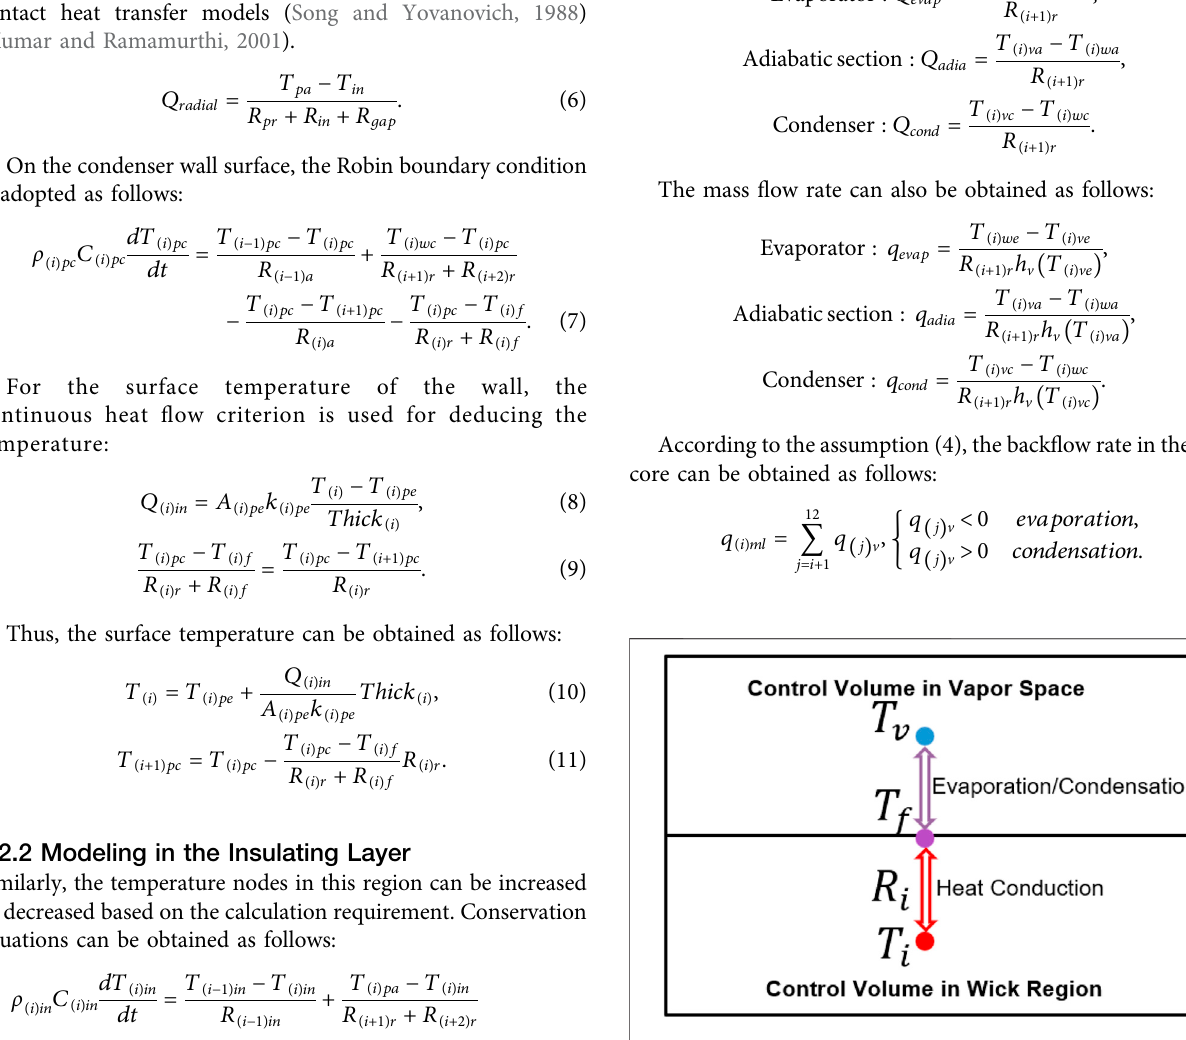
FIGURE 6 | Evaporation/condensation between the wick and the vapor